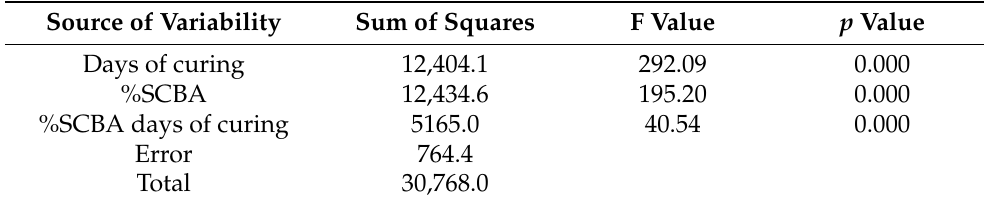
Table 1. Analysis of variance (ANOVA) for the proposed samples and curing time. Source of Variability Sum of